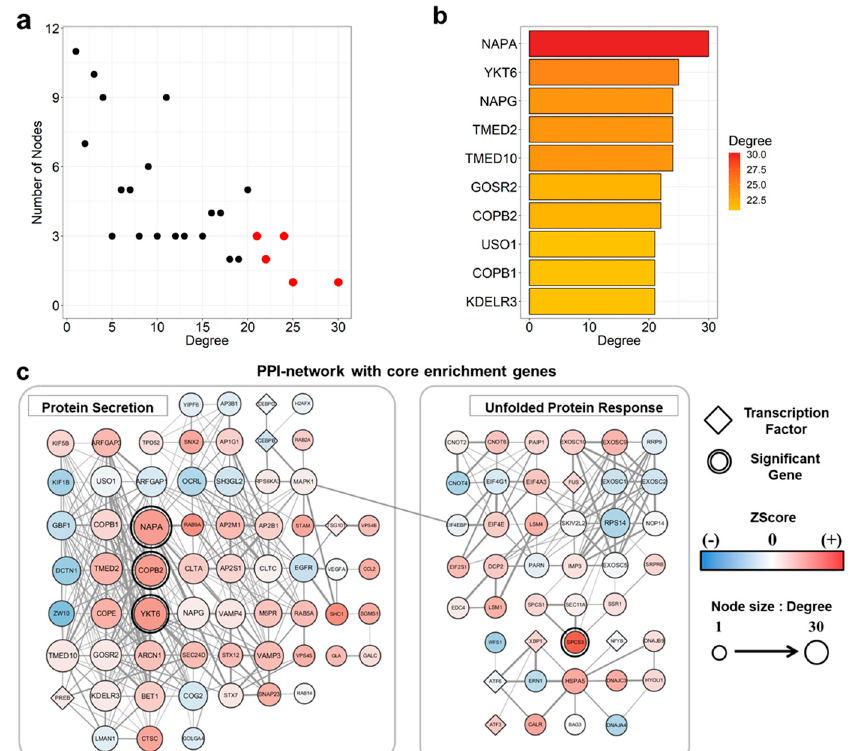
Figure 3. A protein-protein interaction (PPI)-network and its information obtained from protein secretion and unfolded protein response gene sets. ( a ) A Scatter plot showing the degree distribution. The nodes with the top 10 highest degrees were annotated with red dots. ( b ) The profiles and the degrees of the top 10 nodes. The color of the bar indicates the degree of the genes in PPI-network. ( c ) The PPI-network of protein secretion and unfolded protein responses and their link. The colors of nodes indicate up- or down-regulated genes. Red nodes indicate up-regulation and blue nodes indicate down-regulation. The sizes of the nodes are proportional to the degrees of the nodes. The identified novel genes were marked with double circles.